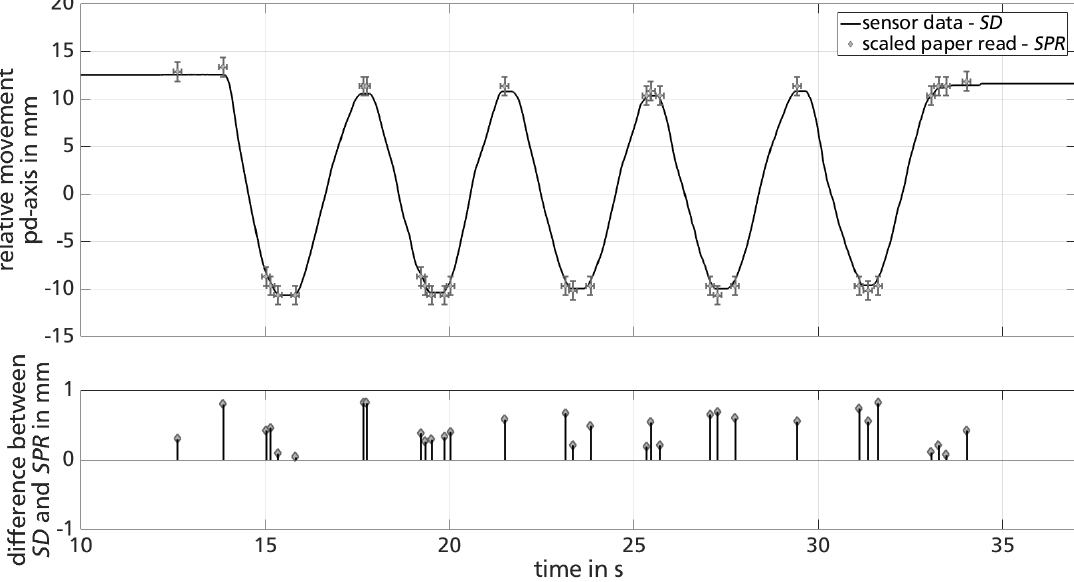
Figure 9. Representative plot of sensor data and scaled paper read ( top ) and calculated difference ( bottom ) of partic. 2 at 0.25 Hz.